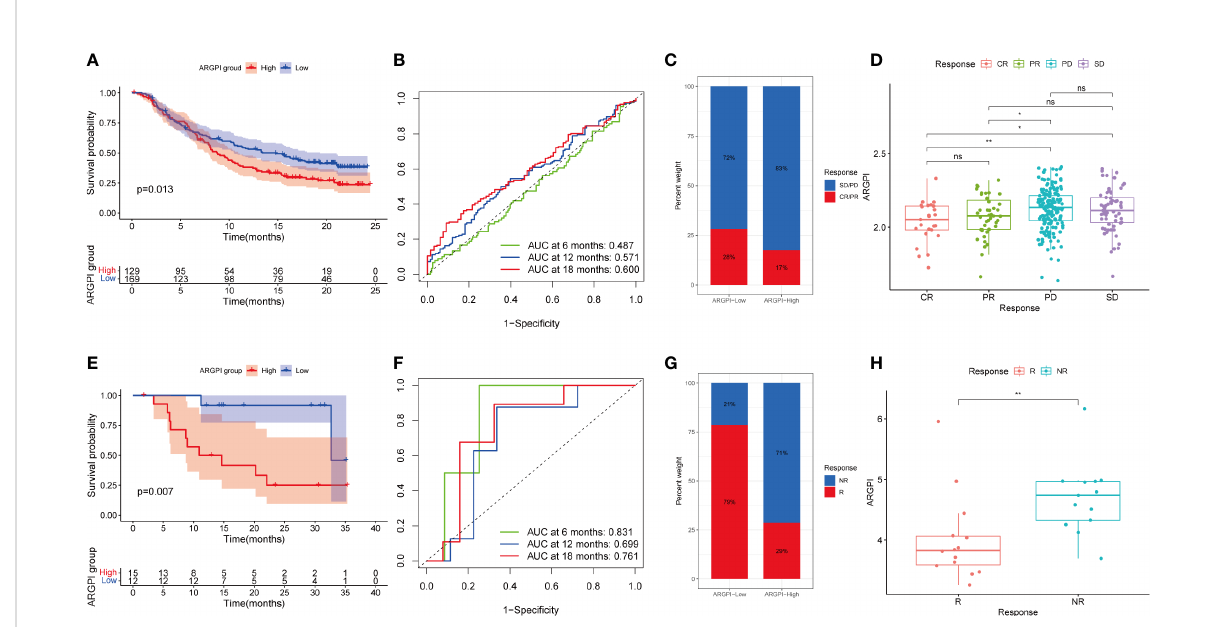
FIGURE 8 Validation of ARGPI ability to predict therapeutic bene fi t in ICI therapy. (A) Kaplan-Meier survival analysis of ARGPI subgroups in the IMvigor210 cohort. (B) ROC analysis of OS with ARGPI at 6-, 12- and 18-months follow-up in the IMvigor210 cohort. (C) Clinical response rates to ICI immunotherapy in the high and low ARGPI groups in the IMvigor210 cohort. (D) ARGPI distribution in different ICI immunotherapy clinical response status groups in the IMvigor210 cohort. (E) Kaplan-Meier survival analysis of ARGPI subgroups in the GSE78220 cohort. (F) ROC analysis of OS with ARGPI at 6-, 12- and 18-months follow-up in the GSE78220 cohort. (G) Clinical response rates to ICI immunotherapy in the high and low ARGPI groups in the GSE78220 cohort. (H) ARGPI distribution in different ICI immunotherapy clinical response status groups in the GSE78220 cohort. “ ns ” represents not signi fi cant, “ * ” represents p < 0.05 and “ ** ” represents p <